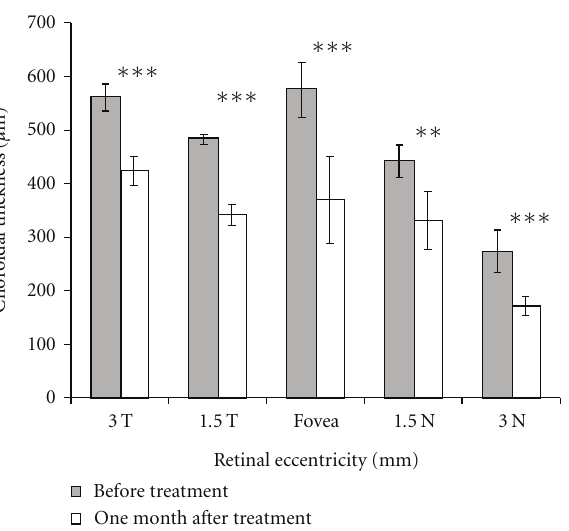
Figure 4: Chart comparing thickness of choroid at 3 mm temporal to fovea, 1.5mm temporal to fovea, under the fovea, 1.5mm nasalto fovea, and 3 mm nasal to fovea before and after treatment with PDT. Error bars represent one standard deviation. At all points, there was a significant reduction in choroidal thickness (the Mann-Whitney test): ∗∗∗ P < 0 . 01, ∗∗ P < 0 .